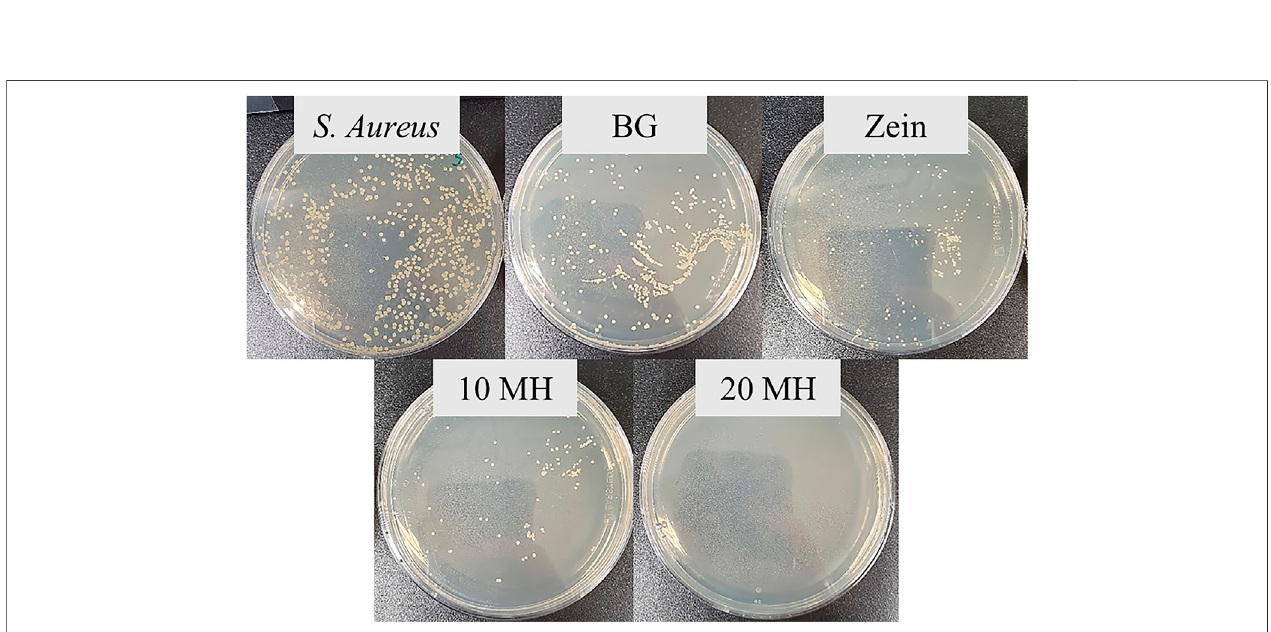
FIGURE 9 | Agar plates after 8 h incubation of S. aureus with supernatants of the 10 − 5 dilution of each sample.